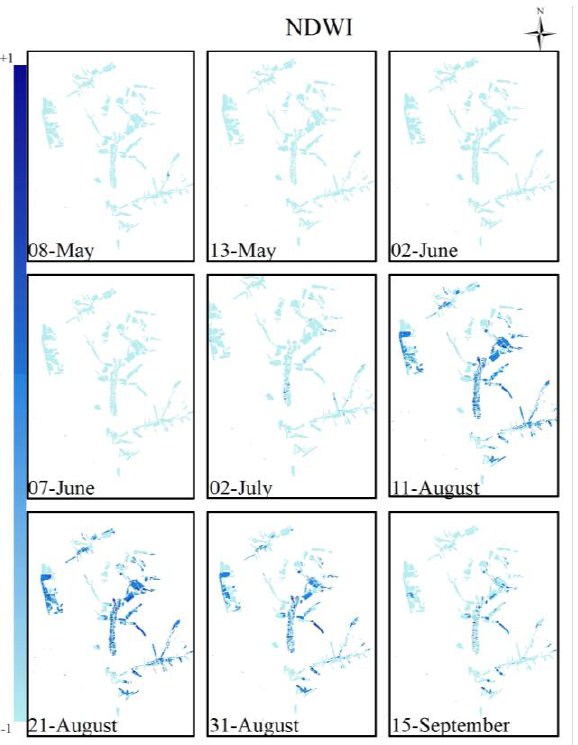
Figure 3. Spatial distribution of NDVI in Bornuur soum of Tuv province using Sentinel-2 with crop growing season of